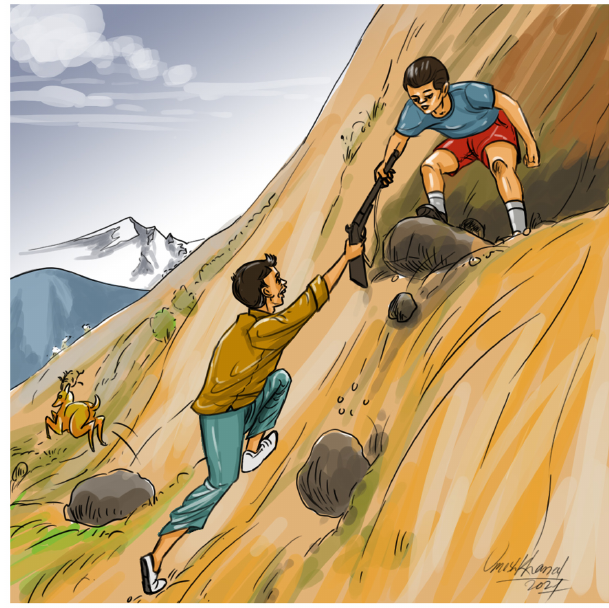
Figure 1. Graphical illustration of the scene of the